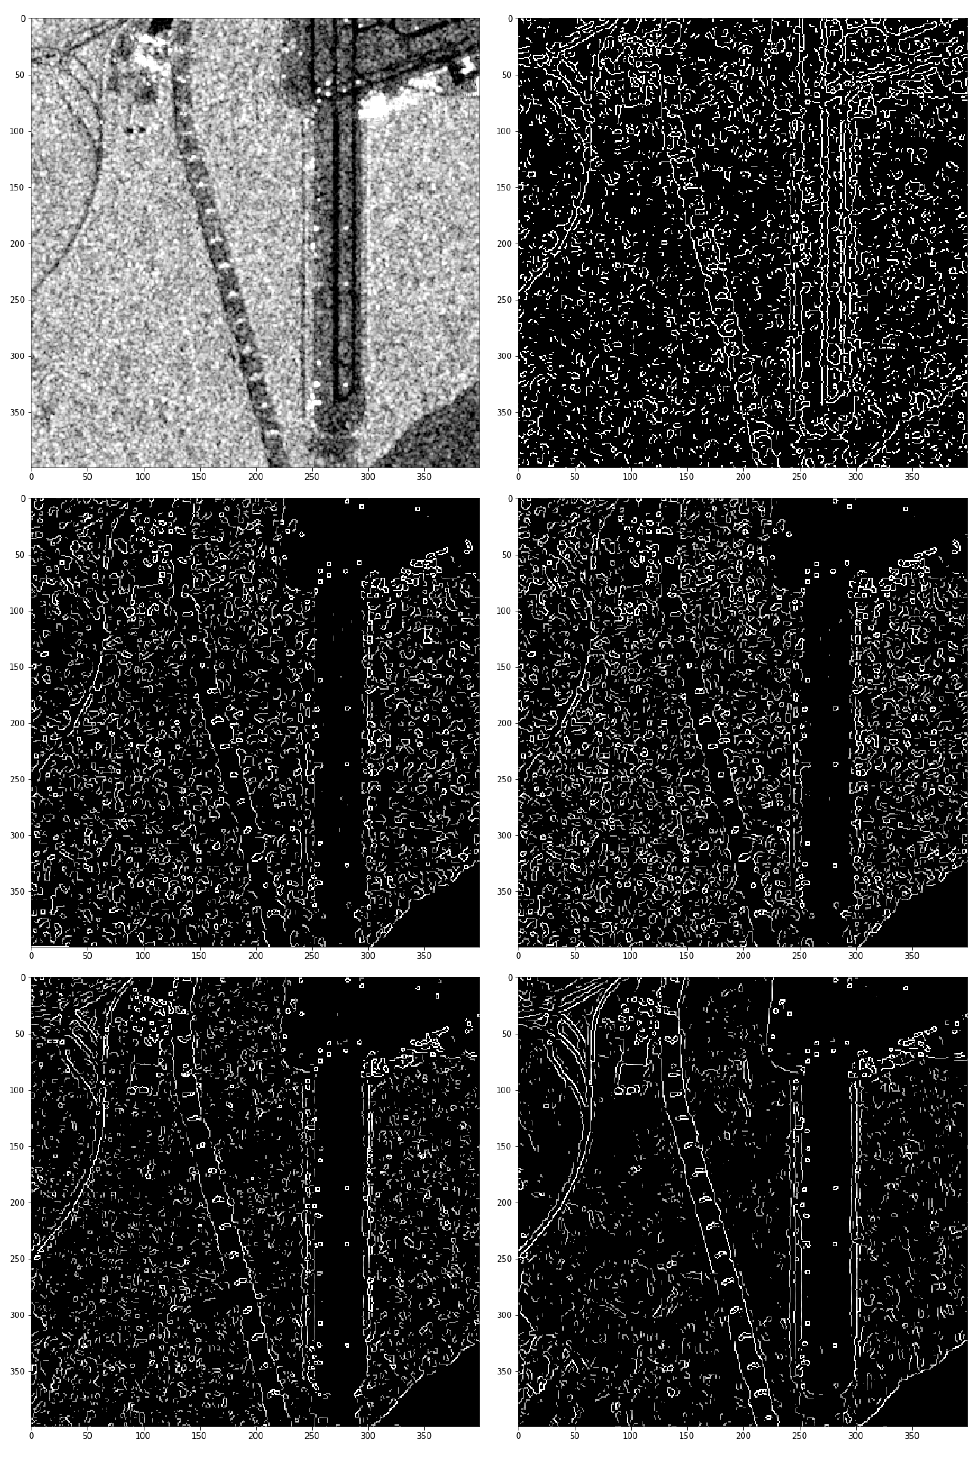
Figure 6. Illustrating edge preservation. From left to right, top to bottom: a spacial subset of the airport image for 27 October; canny edges for the refined Lee filter; for the Gamma MAP filter; for the Frost filter; for the EMD filter; and for the